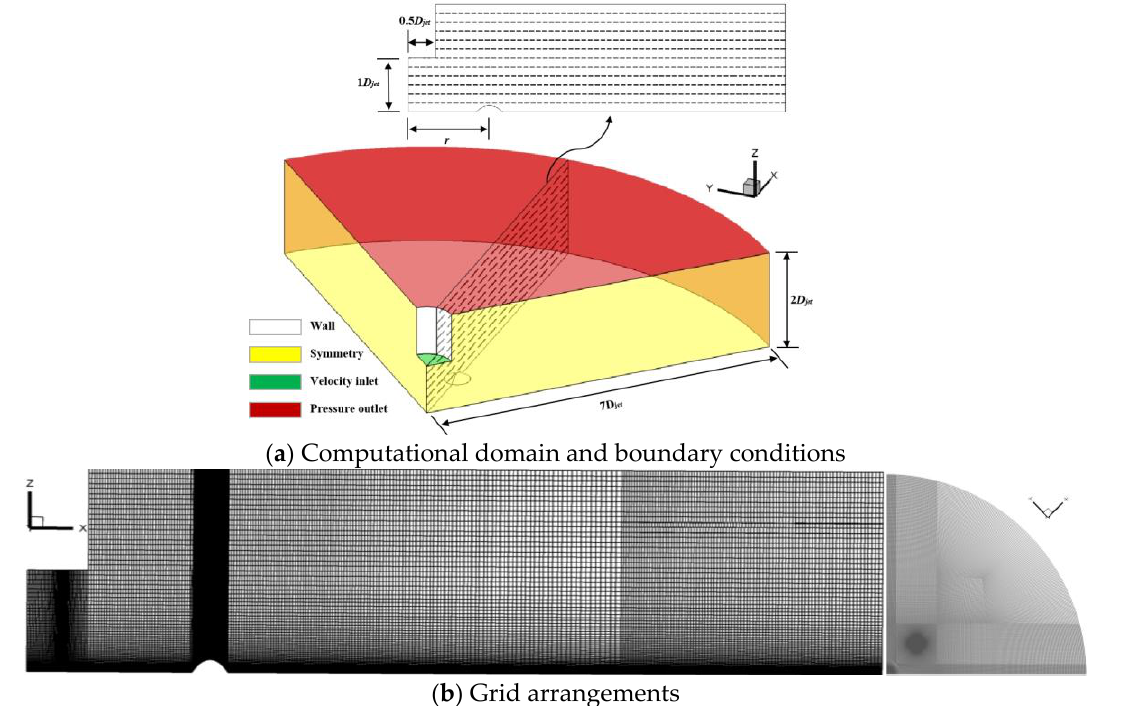
Figure 2. Computational domain, boundary conditions, and grid arrangements.